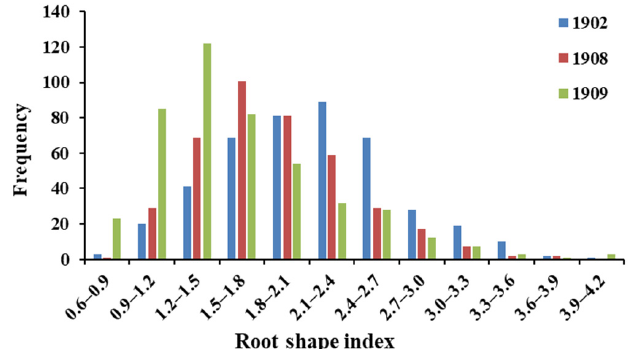
Figure 2. Frequency distribution of the root shape index in three radish F 2 populations.